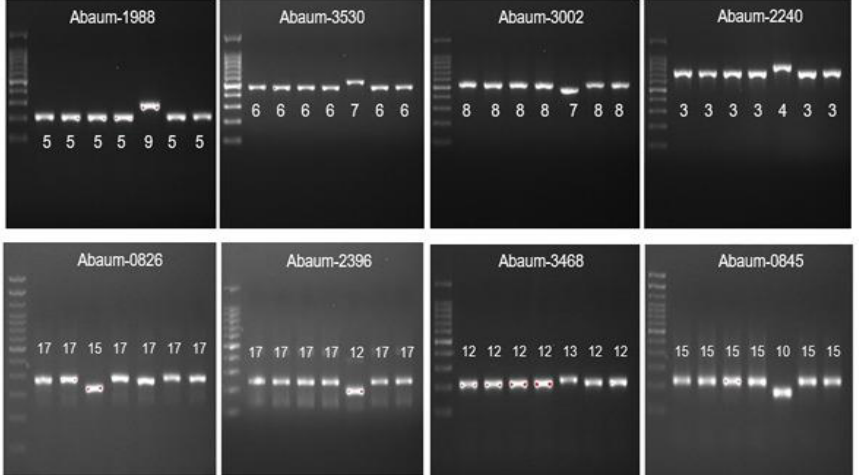
Figure 4. The MLVA typing of CRAb-cc isolates from Dr. Saiful Anwar Hospital, Malang. Lane 1 = DNA ladder; lane 2 = MLG-2; lane 3 = MLG-3; lane 4 = MLG-28; lane 5 = MLG-26; lane 6 = MLG-35; lane 7 = MLG-31; lane 8 = MLG-32.